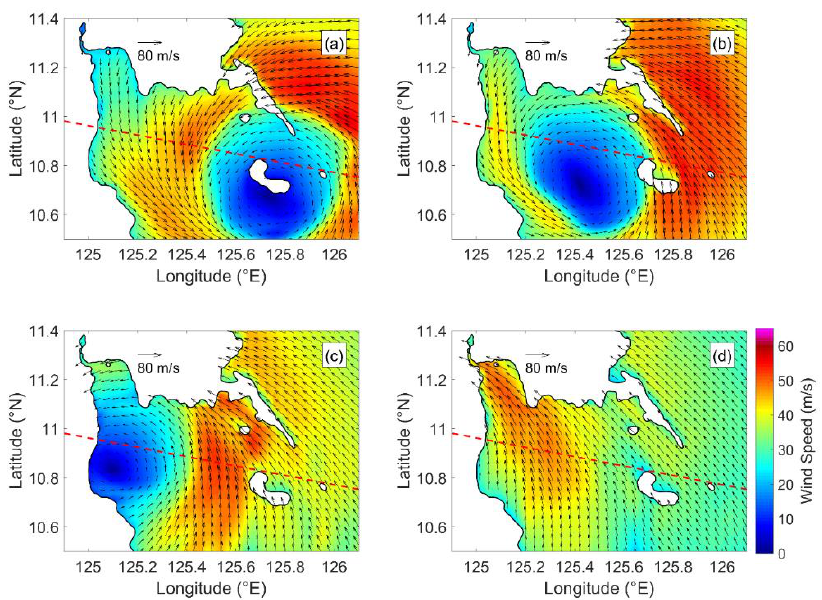
Figure 10. Snapshots of the 10-m winds by WRF-ARW 3 km at ( a ) 01:00 UTC 8 November 2013; ( b ) 02:00 UTC 8 November 2013; ( c ) 03:00 UTC 8 November 2013 ( d ) 04:00 UTC 8 November 2013. The dashed red line denotes the JMA best track. The color shading indicates the 10-m wind speed in m/s. The 10-m winds shown in this figure have been interpolated to the grids of the storm surge model. The arrows depict the wind direction per every 15 grids over the domain.